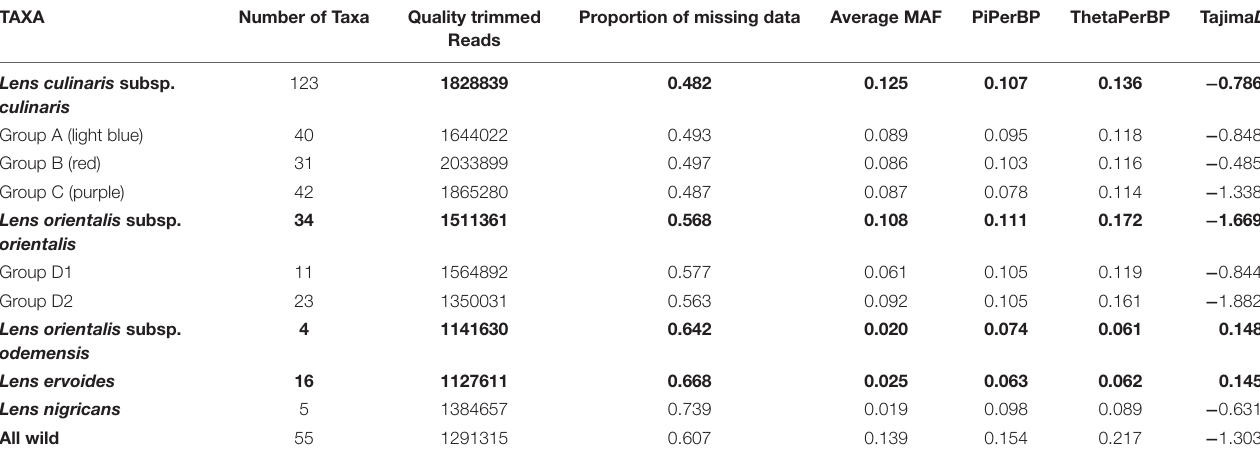
TABLE 1 | Genotyping-by-sequencing (GBS) statistics and genetic diversity measures based on 87,647 SNPs for species (bold) and selected groups within the Lens genus. TAXA Number of